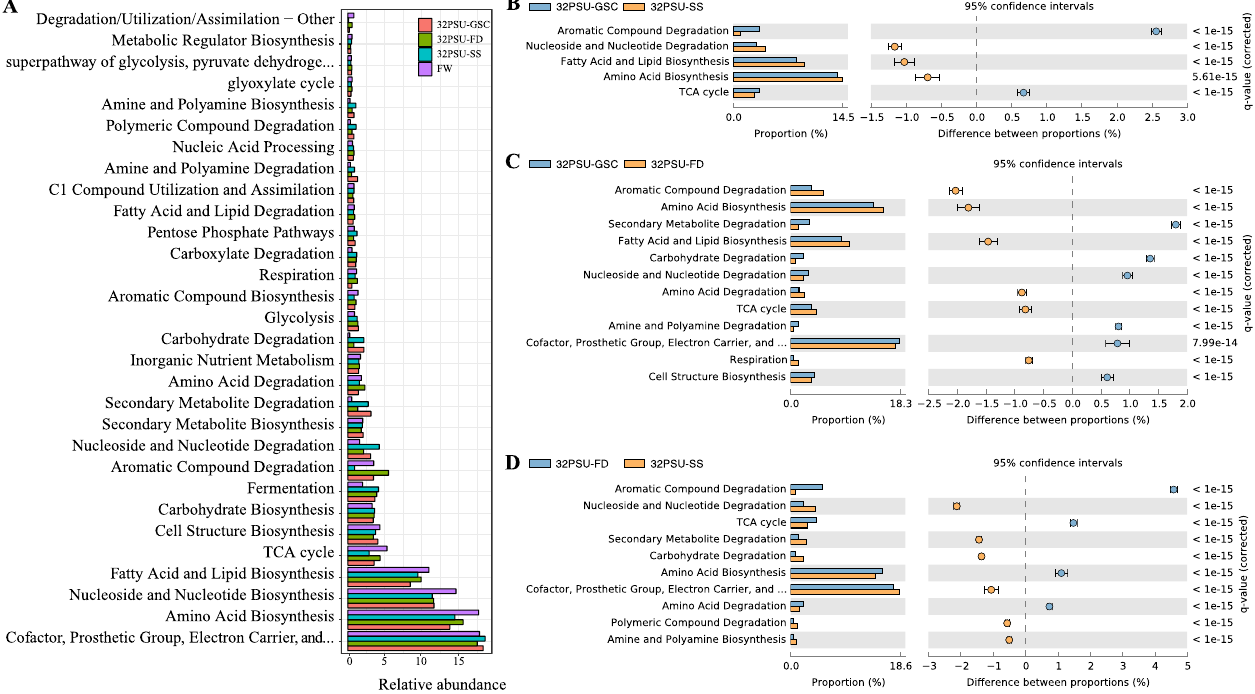
Figure 5. Relative abundance proportion of metabolic pathway (level 2). FW: Fresh water previous treatment group, GSC: gradual salinity change at 10 PSU, 20 PSU, and 32 PSU groups; 32 PSU-SS Salinity shock at 32-PSU group; 32 PSU-FD: Salinity shock at 32 PSU group previously feeding with a functional diet. ( A ) Metabolic pathways abundance in freshwater (FW) and different seawater treatment; ( B – D ) STAMP analysis of level 2 metabolic pathways with different abundance among samples at 32 PSU. PICRUSt2 inferred metabolic pathways with a filter size of 0.5.